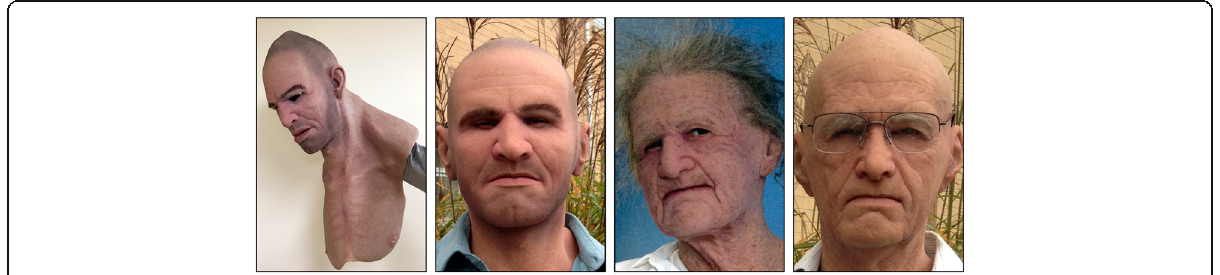
Fig. 1 Hyper-realistic silicone masks. Images show (from left to right) a young male mask (YMM), followed by a young male mask (YMM), an old female mask (OFM) and an old male mask (OMM) worn by author